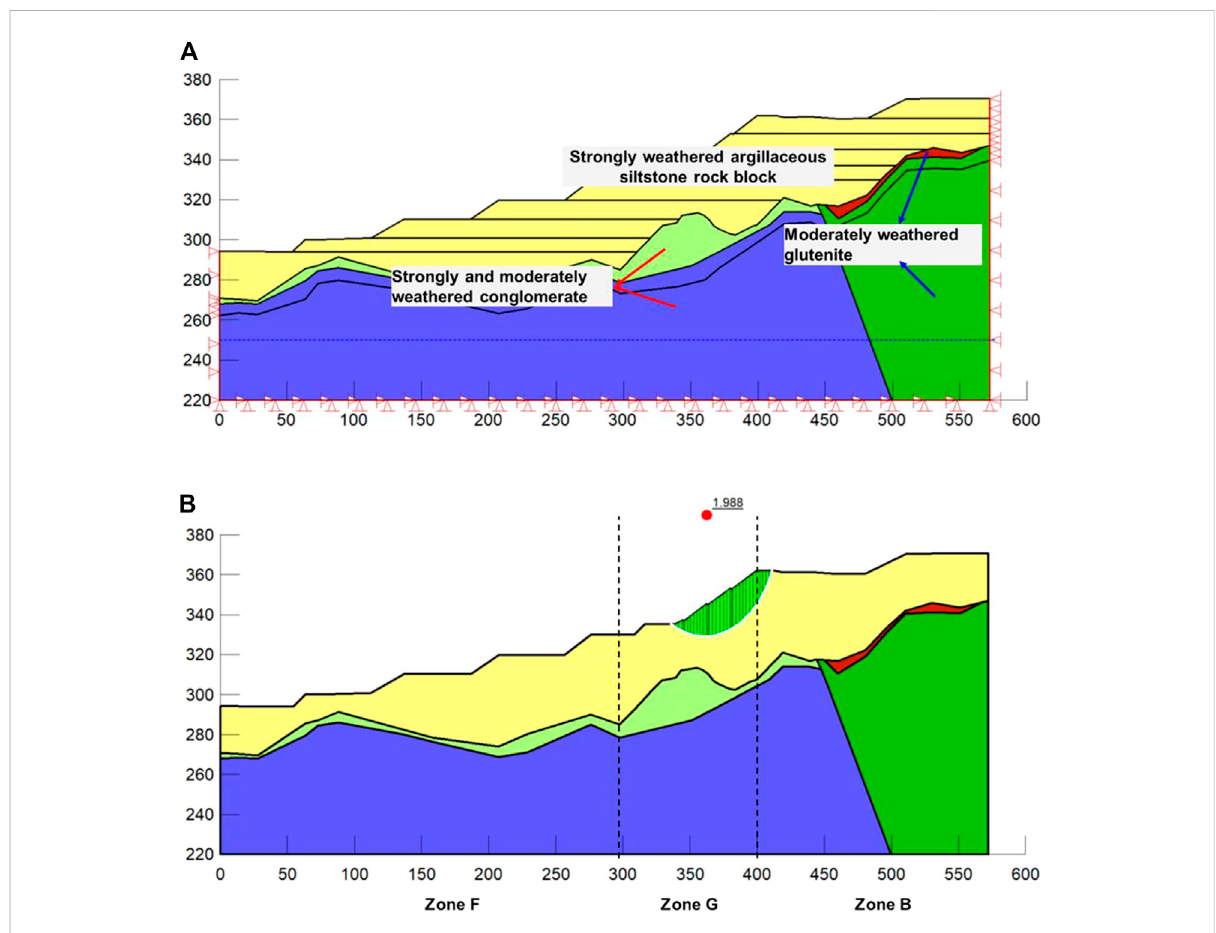
FIGURE 13 (A) Numerical model and the (B) potential sliding surface of the deposit